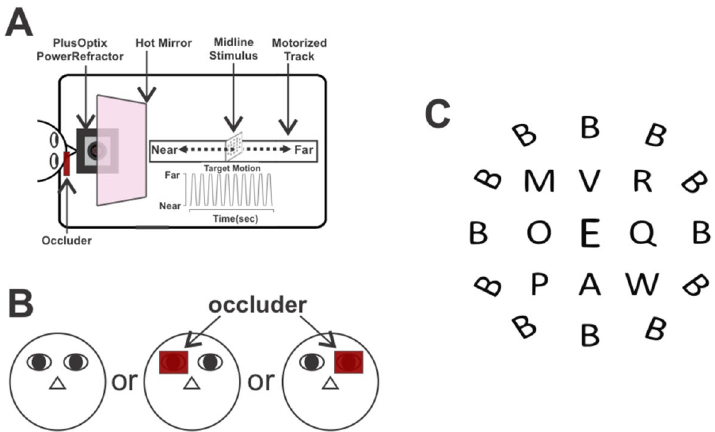
Figure 1. Experimental paradigm. (A) The target moved back and forth on the midline (33 cm–67 cm from observer) for 63 s at 30 cm/s with an acceleration of 50 cm/s 2 on a motorized track while accommodation and vergence were recorded. (B) Viewing was either binocular or monocular with the left eye or the right eye covered with an IR-passable occluder. (C) Observers fixated the central "E" of the letter matrix